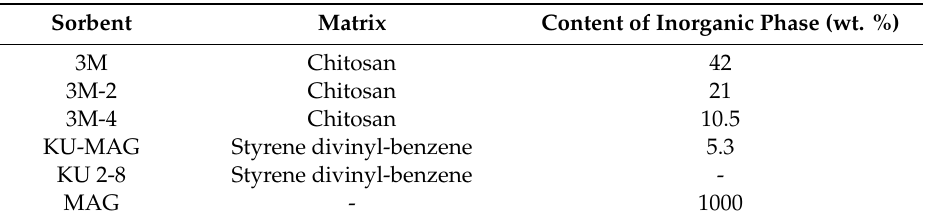
Table 4. Markings and characteristics of the